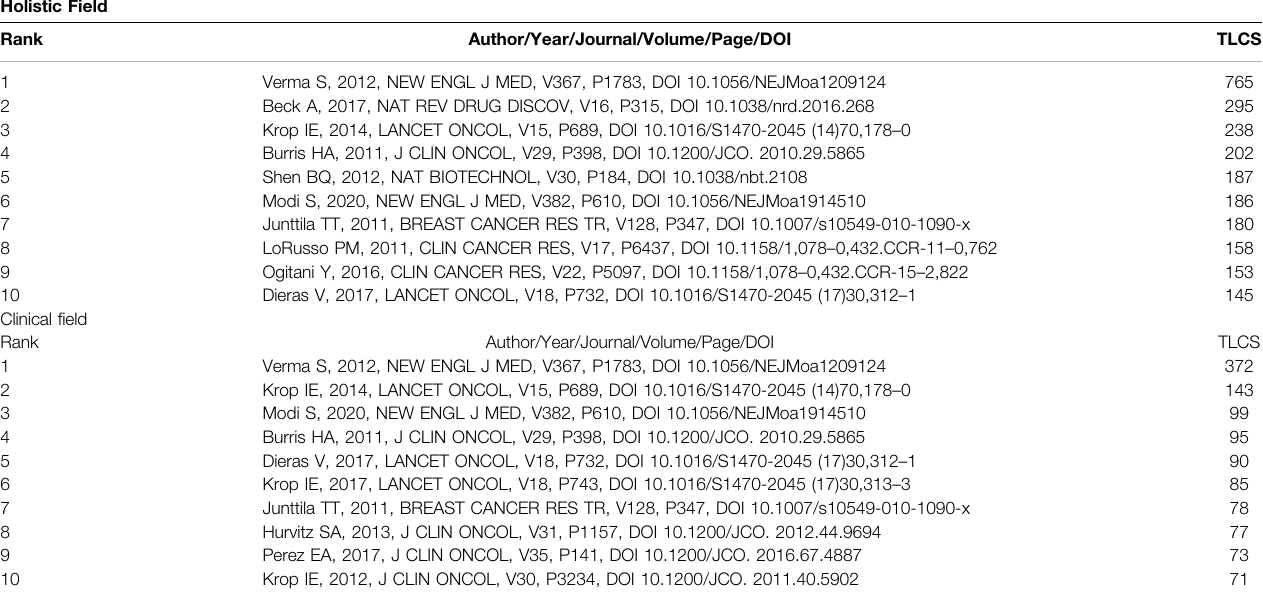
TABLE 4 | The top 10 cited references related to ADC research in the solid cancer fi eld from 2011 – 2022. Holistic